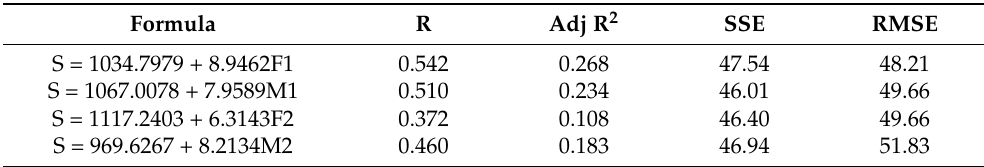
Table 4. Regression formulae for females ( n = 30) with its correlation coefficient (R), adjusted determination coefficient (Adj R 2 ), standard error of estimate (SEE) and root mean square error